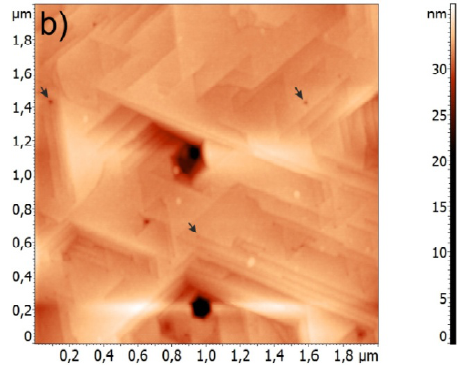
Fig. 4. AFM images of sample C. Topography on scale (a) 5x5  m 2 and (b) 2x2  m 2 as well as (c) phase images of the same area as in panel (b). Arrows in (b) and (c) show a few identical defect